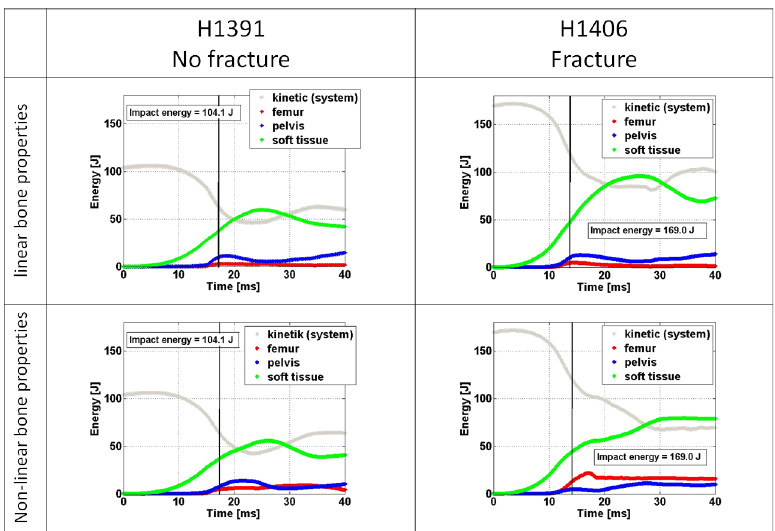
Fig 9. Energy absorption of the main structures of the specimens during impact according to simulation results for linear FEMs (top row) and non-linear FEMs (bottom row). The vertical lines indicate the time of computationally measured peak impact